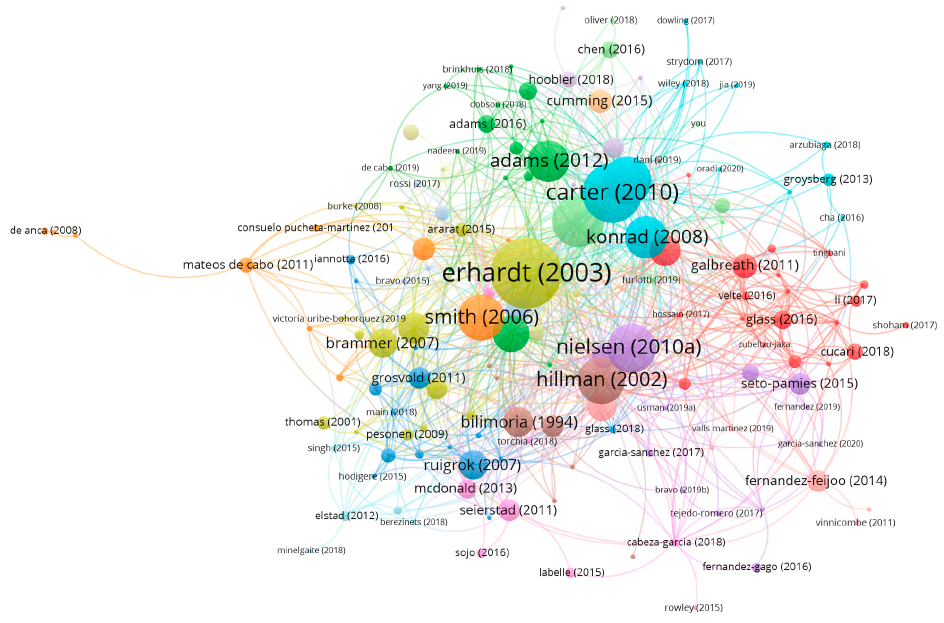
Figure 3. VOSviewer network visualization of the bibliometric citation